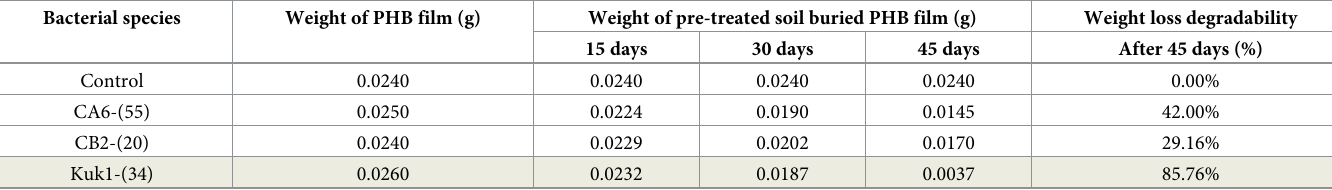
Table 5. Weight loss degradability of PHB film after different incubation time in un-optimised conditions. Bacterial